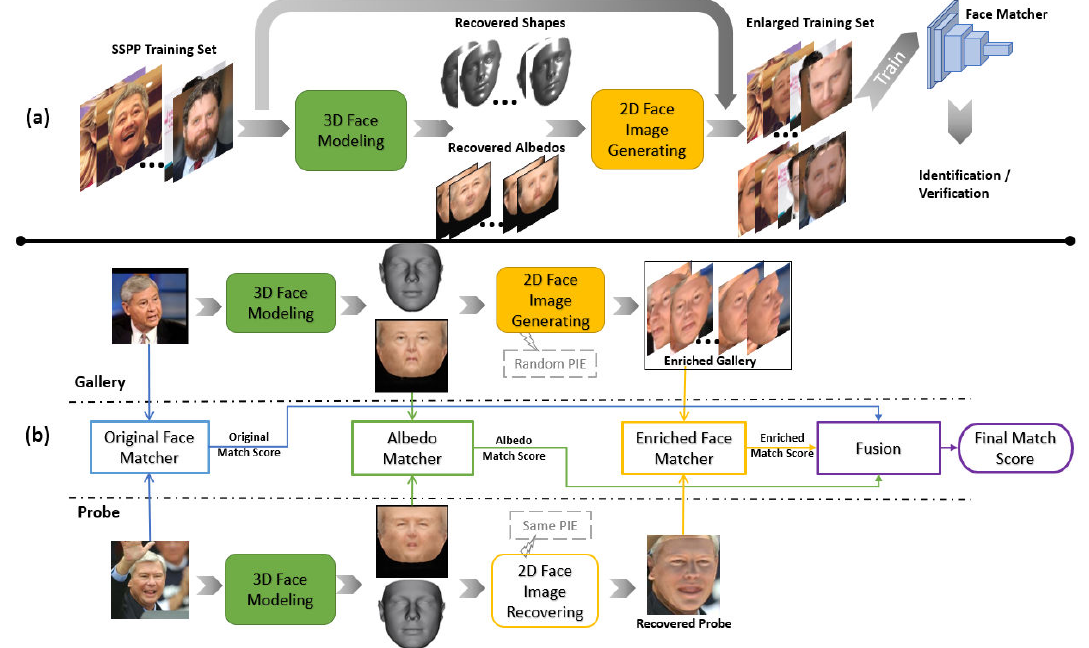
Figure 3. ( a ) Pipeline of SSPP face recognition via enriching intra-variation. ( b ) Pipeline of SSPP face recognition via enriching both intra-variation and invariant